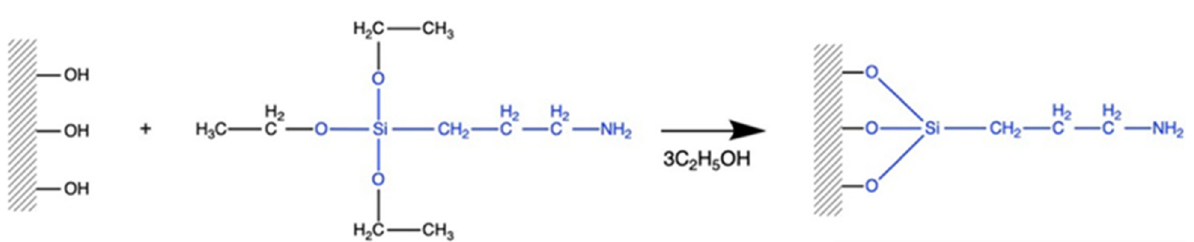
Figure 5. Effect of pH on the adsorption capacity ( C 0 = 100 mg/L, T = 25 °C, t = 8 h, n = 100 rpm). The maximum value of the adsorption capacity of the modified zeolite was 6.06 mg/g at a pH of 5, which was higher than the adsorption capacity of the natural zeolite (4.05 mg/g), which confirms that we successfully performed the modification. When we in- creased the pH from 5, the adsorption capacity decreased the presence of the Cu(II) ion species in the aqueous solution. Therefore, we chose a pH of 5 as the optimal pH for the adsorption studies of the modified zeolite. 3.2.2. Effect of Initial Concentration and Time We studied the effect of time on Cu (II) adsorption at a pH of 5 by using solutions with different initial concentrations of Cu(II). The result is shown in Figure 6. The increase in the adsorption capacity was rapid in the first 30 min, slowed during the next 8 h, and then became constant. The maximum adsorption capacity increased from 4.50 to 20.66 mg/g when the initial concentration of the Cu(II) increased from 50 to 400 mg/L. A higher value of the initial concentration gradient provided a significant driving force in the adsorption process and thus increased the adsorption capacity.